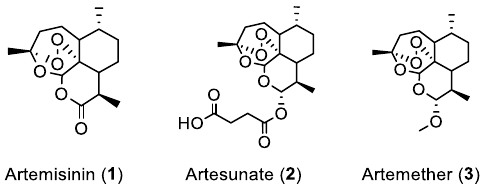
Figure 1. Artemisinin and related API derivatives artesunate and